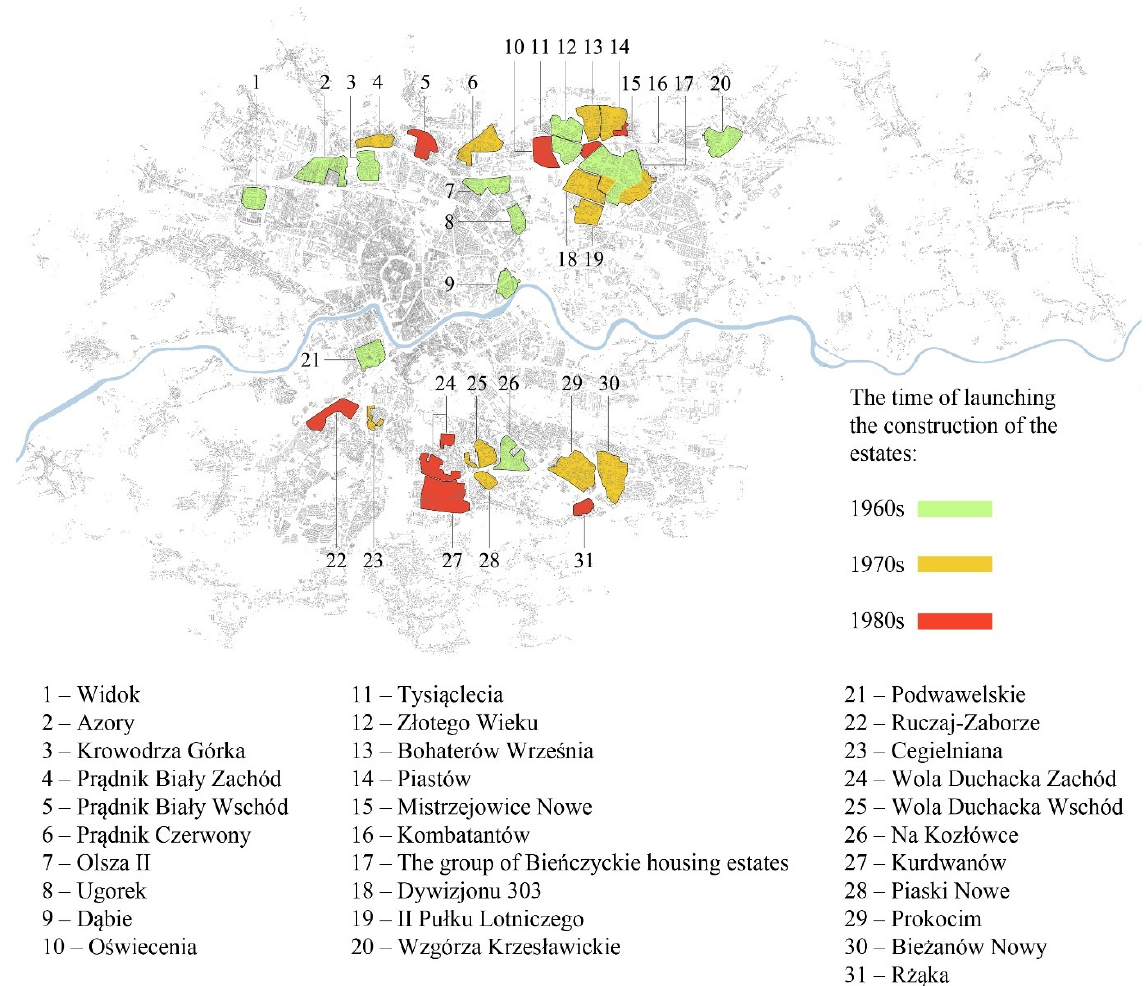
Figure 1. Arrangement of large-panel housing estates in the structure of Cracow.